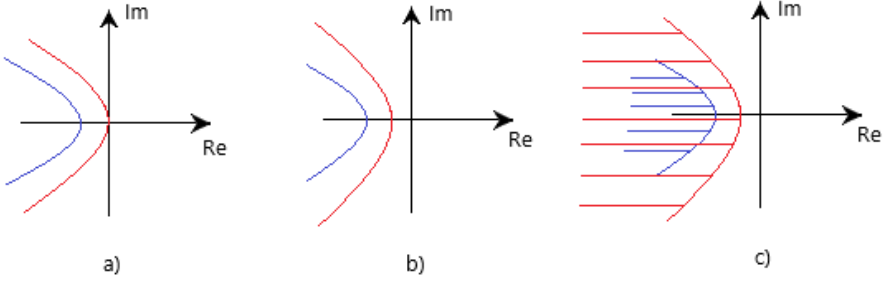
Figure 1. ( a ) spectrum of the operator L 1 on H k ( R ) 2 , the red curve corresponds to the operator ∂ zz + c ∂ z , while the blue curve corresponds to the operator (cid:101)∂ zz + c ∂ z − κ e − κ ; ( b ) spectrum of the operator L 1, α on H k α ( R ) 2 ; ( c ) spectrum of the operator L α on H k α ( R d ) 2